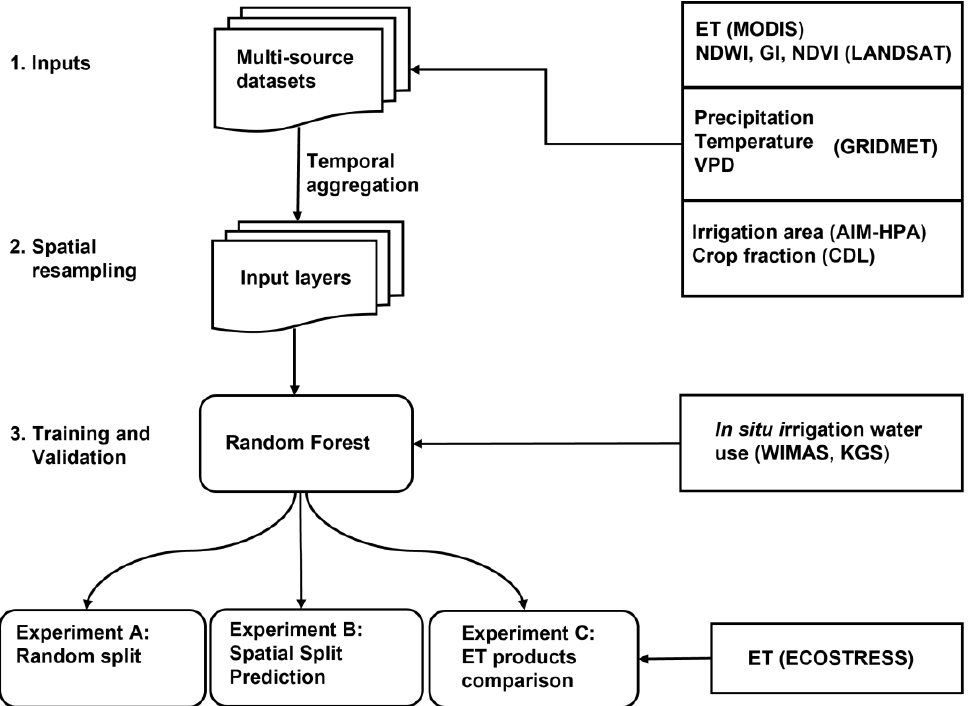
Figure 2. Flowchart of a machine learning-based estimation of the spatial irrigation amount by fusing hydrometeorological data, in situ irrigation water use records, multi-source remote sensing data, and derived irrigation maps and crop fractions.